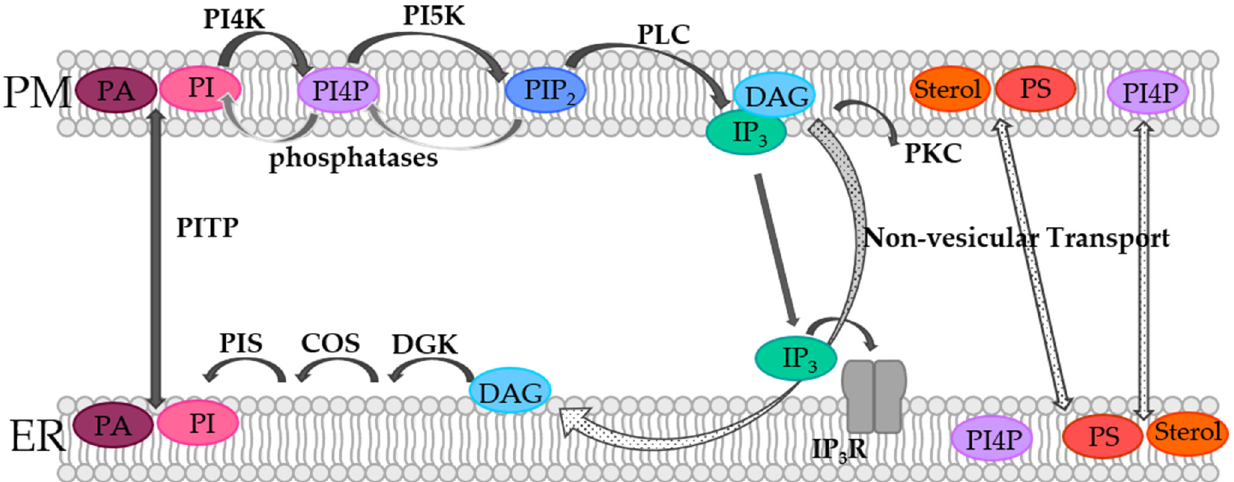
Figure 1. Lipid transport and phosphoinositide (PI) cycle at the ER-PM contact sites. PI is consecu- tively transformed at the PM into PI4P by PIP4K and PIP 2 by PIP5K (PIP 2 can be converted to PI4P or PI by phosphatases). PM-receptor stimulation can trigger PLC mediated hydrolysis of PIP 2 to form DAG and IP 3 . While DAG can activate PKC or some ion channels, IP 3 activates the ER located IP 3 R. Non-vesicular transport mechanisms (see Section 5) can transport DAG to the ER membrane, where it is converted to PI. PITPs transport PI back to the plasma membrane. Furthermore, sterols, PS, and PI4P are transported between the two membranes via non-vesicular transport (see Section 5). In the PM, PI species are phosphorylated by phosphatidylinositol-4-kinase (PI4K) to generate phosphatidylinositol-4-phosphate (PI4P). Consequently, PI(4,5)P2 or short PIP 2 is produced by phosphorylation of